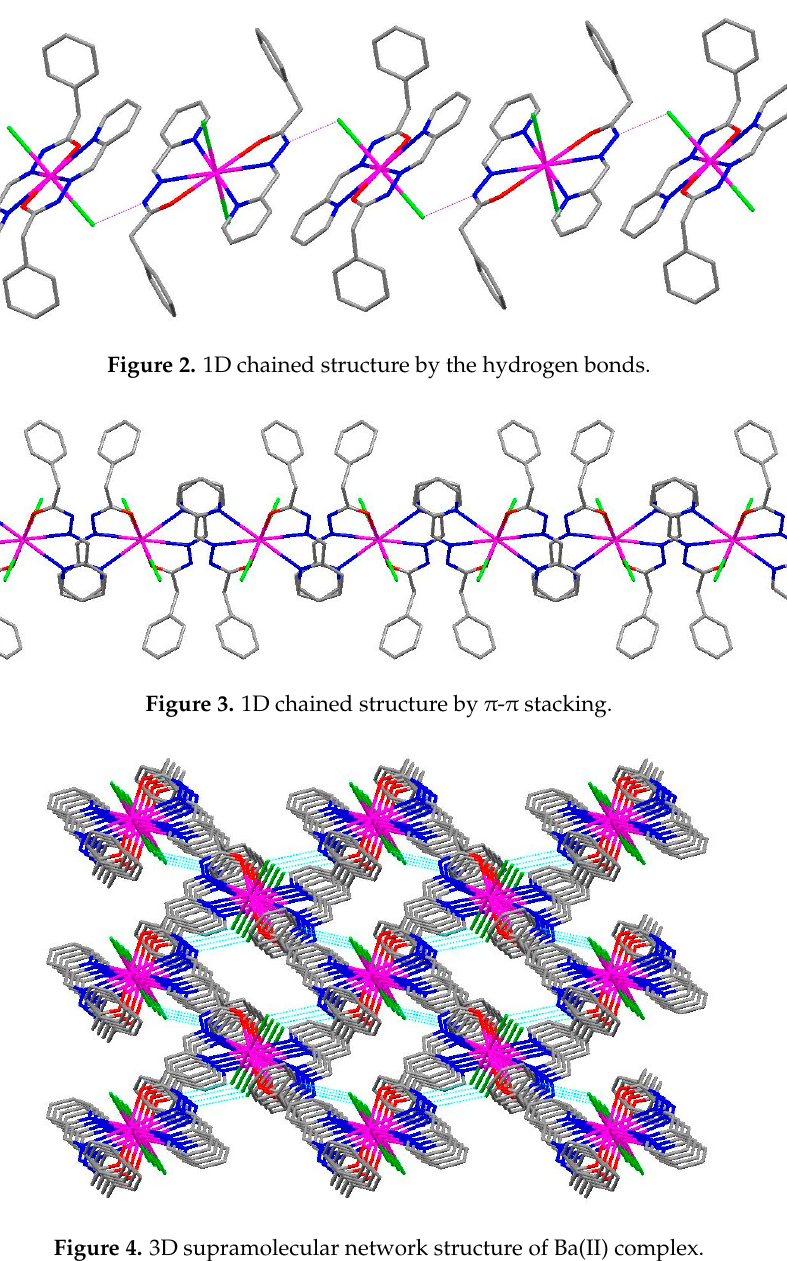
Figure 4. 3D supramolecular network structure of Ba(II) complex.